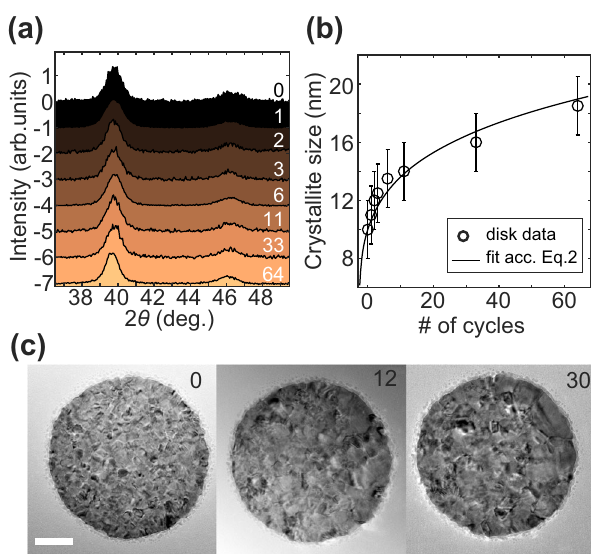
Fig. 3 Grain growth characterization by GIXRD. a GIXRD patterns of Pd nanoparticles (de)hydrogenated N times, with cycle number N indicated in the legend to the right and cycle temperature history as depicted in Supplementary Fig. 4. Patterns are shifted vertically from each other for clarity. b Average crystallite size extracted from GIXRD measurements as function of N . Error bars were estimated based on statistics from multiple measurements for each sample at different incidence angles. The black curve is the fi t to the data according to Eq. 2 with m = 5. c TEM image series of the same representative single Pd particle after 0, 12 and 30 (de) hydrogenation cycles, corroborating substantial grain growth. Scale bar is 50